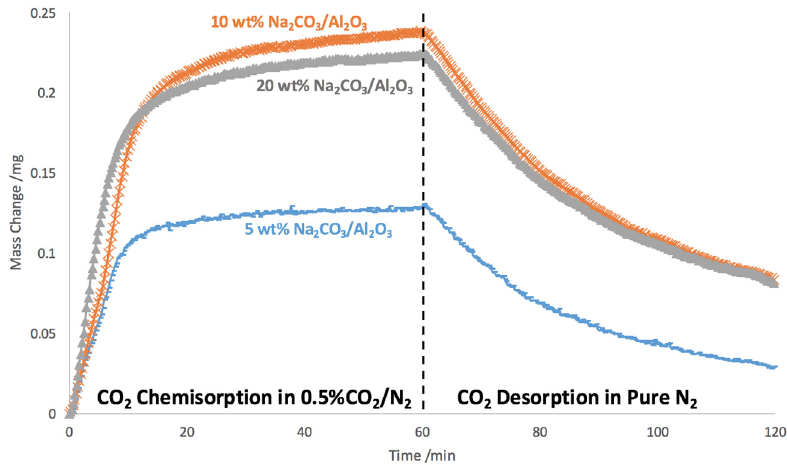
Figure 1. Thermal Gravimetric Analysis (TGA) adsorption studies conducted at 320 °C for 50 mg of powder. Before the adsorption the samples were degassed in 2% H 2 /N 2 for 2 h, then exposed to 0.5% CO 2 in N 2 and subsequently pure N 2 .